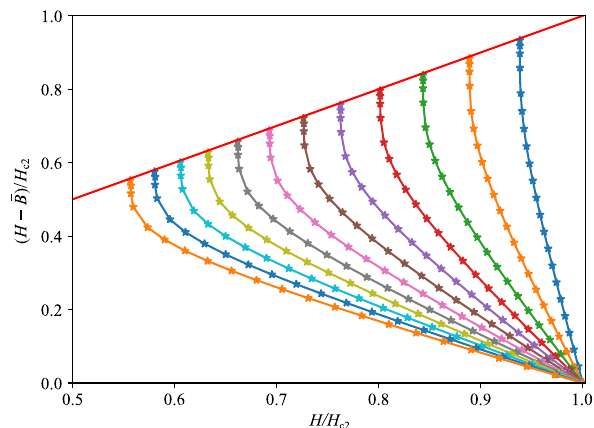
Fig. 3 Variouscriticalfieldsforthechargedpioncondensate.Thethree curves displayed correspond, from the top to the bottom, to H c2 , H c and H c1 , respectively. To generate these data, the pion mass was tuned to m π = ef π ≈ 27 . 9